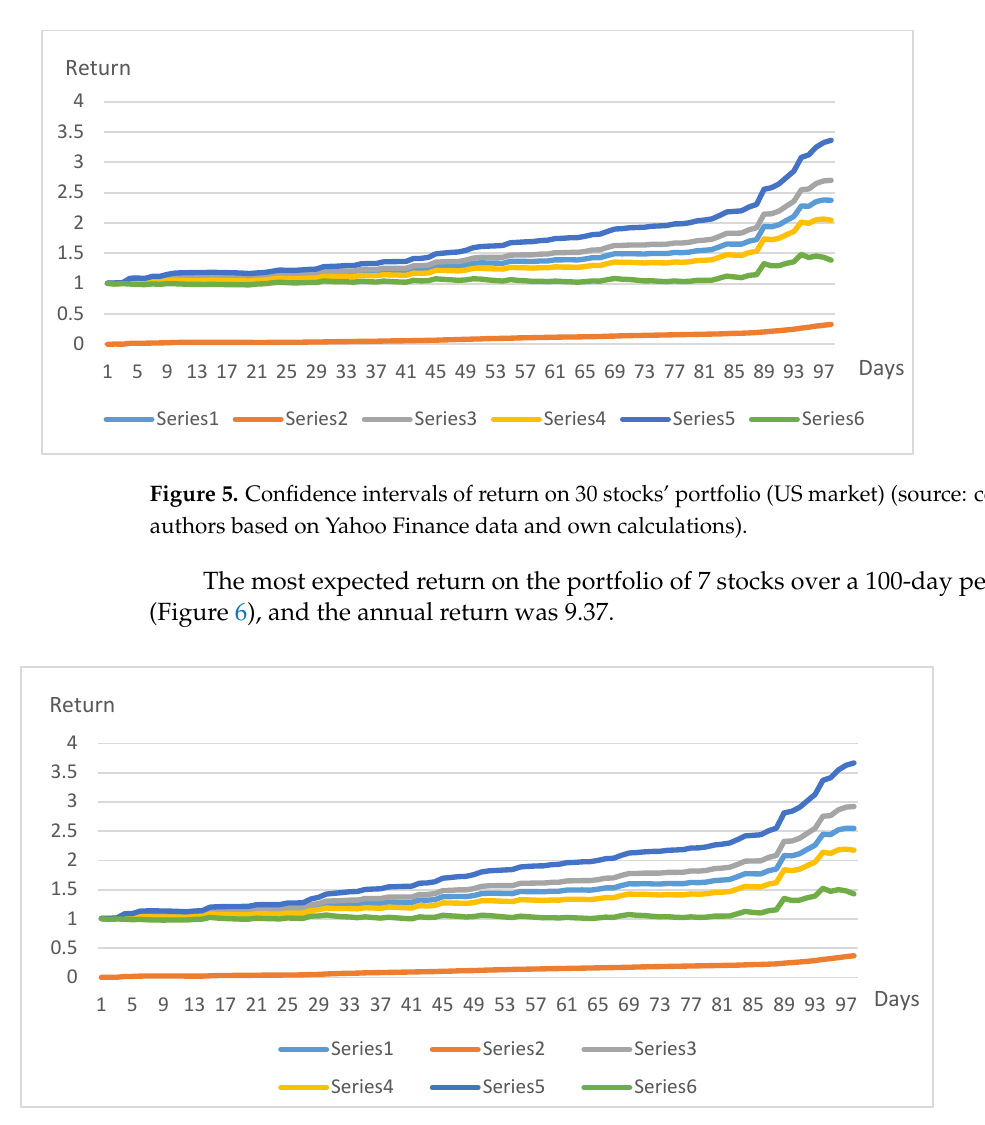
Figure 6. Confidence intervals of return on 7 stocks’ portfolio (US market) (source: compiled by the authors based on Yahoo Finance data and own